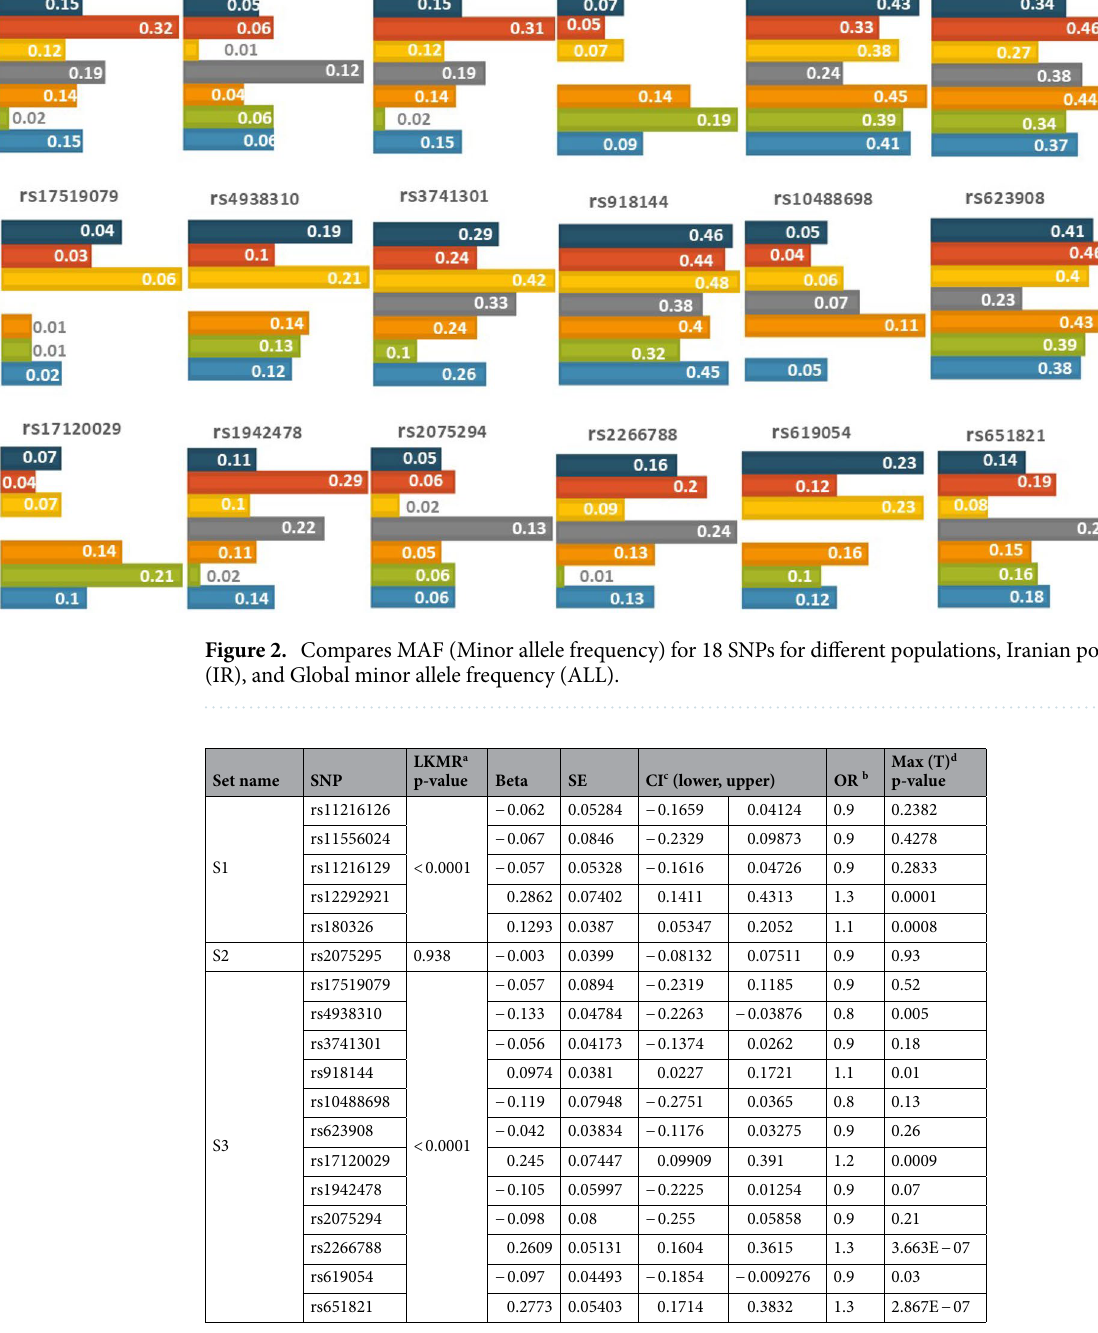
Table 3. Association result for MetS model. a Logistic Kernel machine regression. b Odd ratio for minor allele. c 95% Confidence interval for BETA. d MAX(T) p-value with 1,000,000